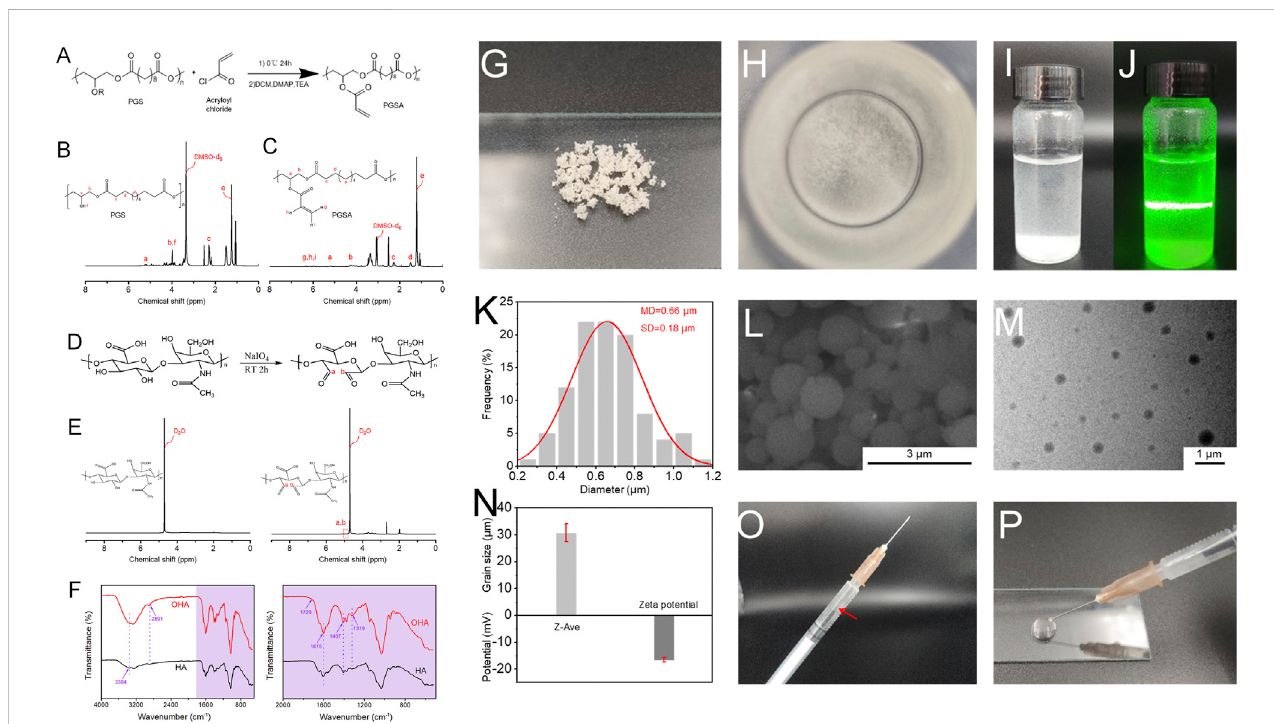
FIGURE 1 (A) ThereactionmechanismrouteofPGSA; (B) 1 H-NMRspectrumofPGS; (C) 1 H-NMRspectrumofPGSA. (D) Thereactionmechanism routeofOHA; (E) 1 H-NMR spectrum ofHA and OHA; (F) FTIRspectrum ofHA andOHA. (G) Apparent morphology of PNs, as revealed bydigital images; (H)